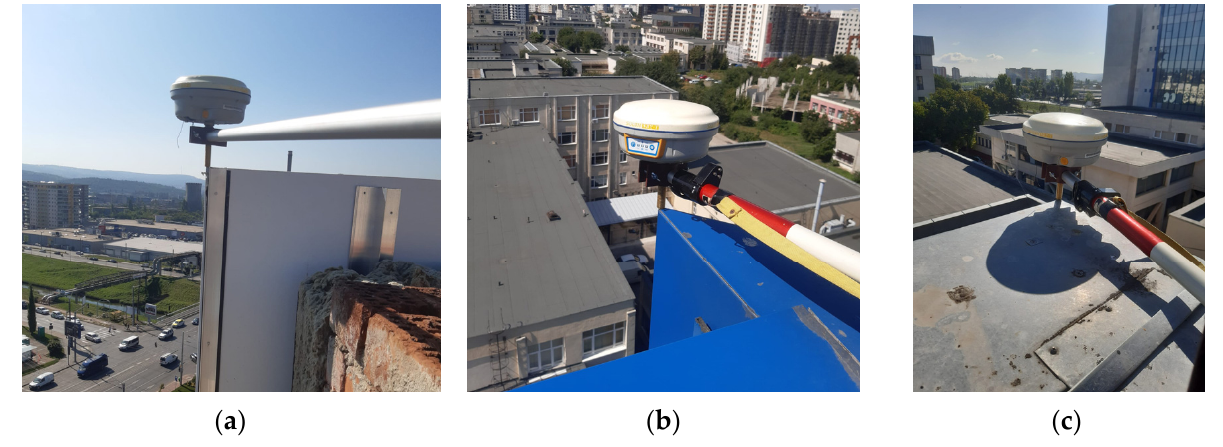
Figure 4. GNSS measurements of roofs’ corners with a specifically crafted dispositive: ( a – c ) example of roofs’ corners for different buildings